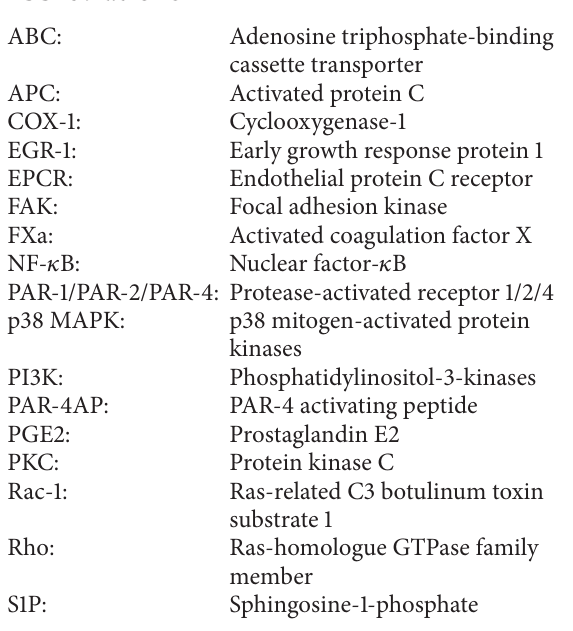
with acute coronary syndrome. The clinical relevance and therapeutic potential of altering S1P levels or receptor activity in atherothrombosis associated diseases is to date unclear and warrants future